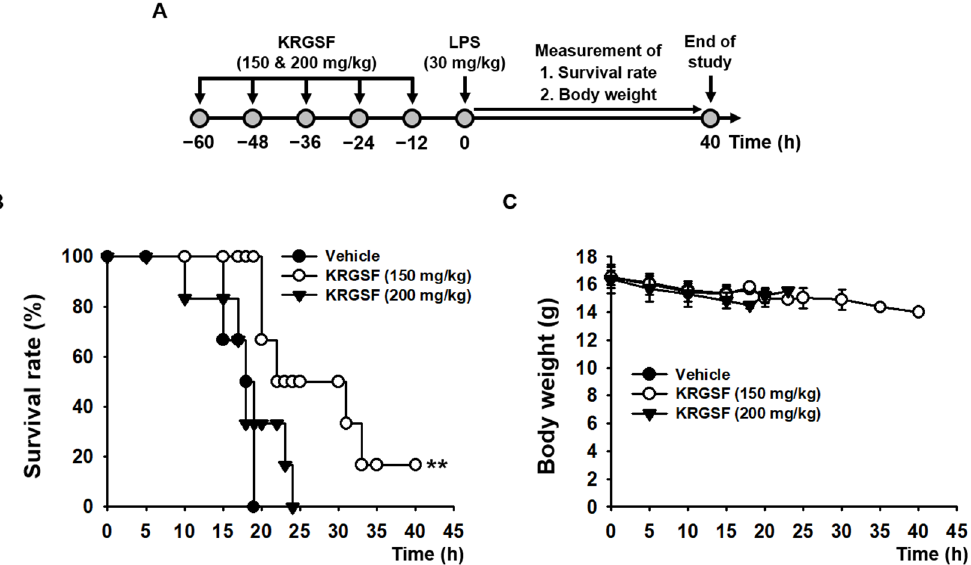
Figure 4. In vivo suppressive role of KRGSF on lethal septic shock in mice. ( A ) Experimental schedule. Mice orally administered KRGSF (150 and 200 mg/kg) were intraperitoneally injected with LPS (30 mg/kg). ( B ) Survival and ( C ) body weight were determined for 40 h. ** p < 0.01 compared to the vehicle-administered negative controls.